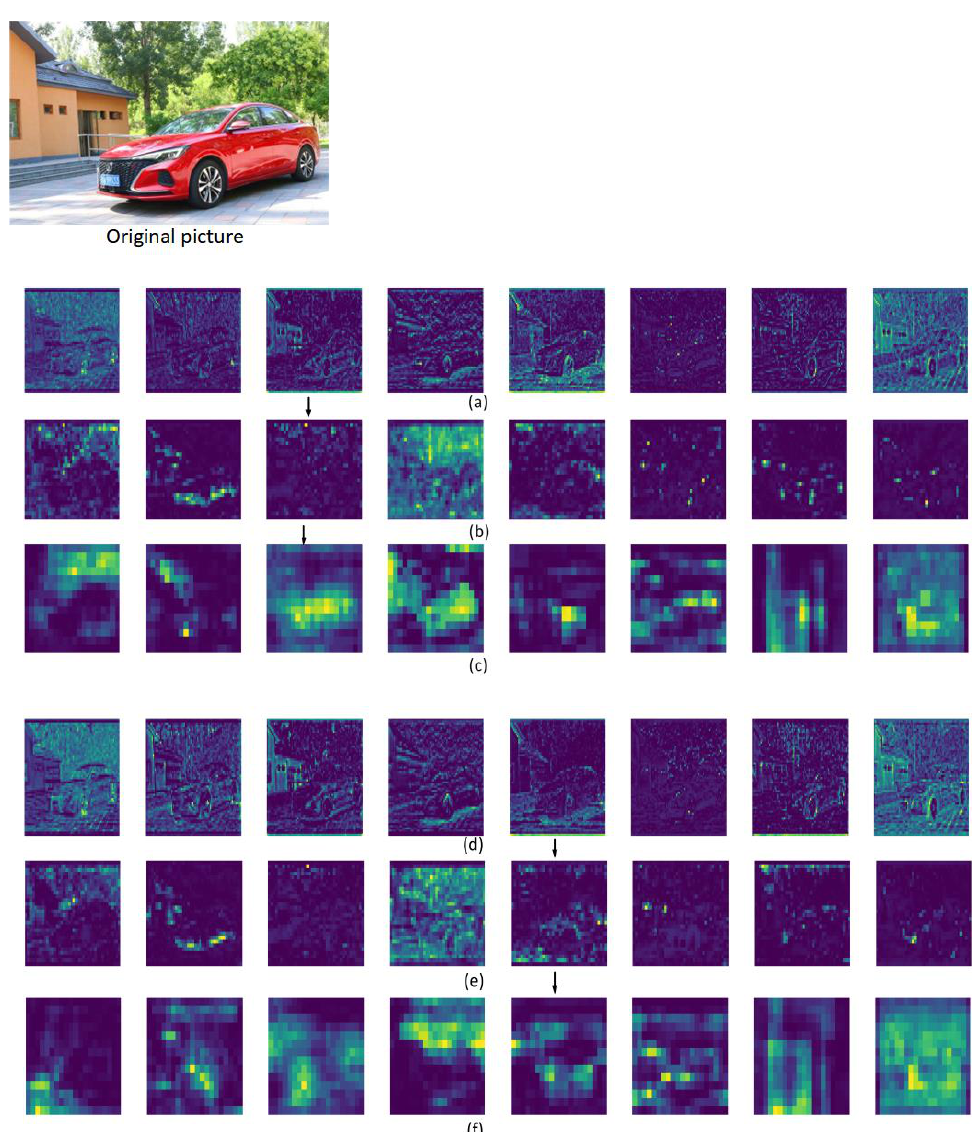
Figure 2. Fine-grained feature maps of the three stages in the backbone network that need to